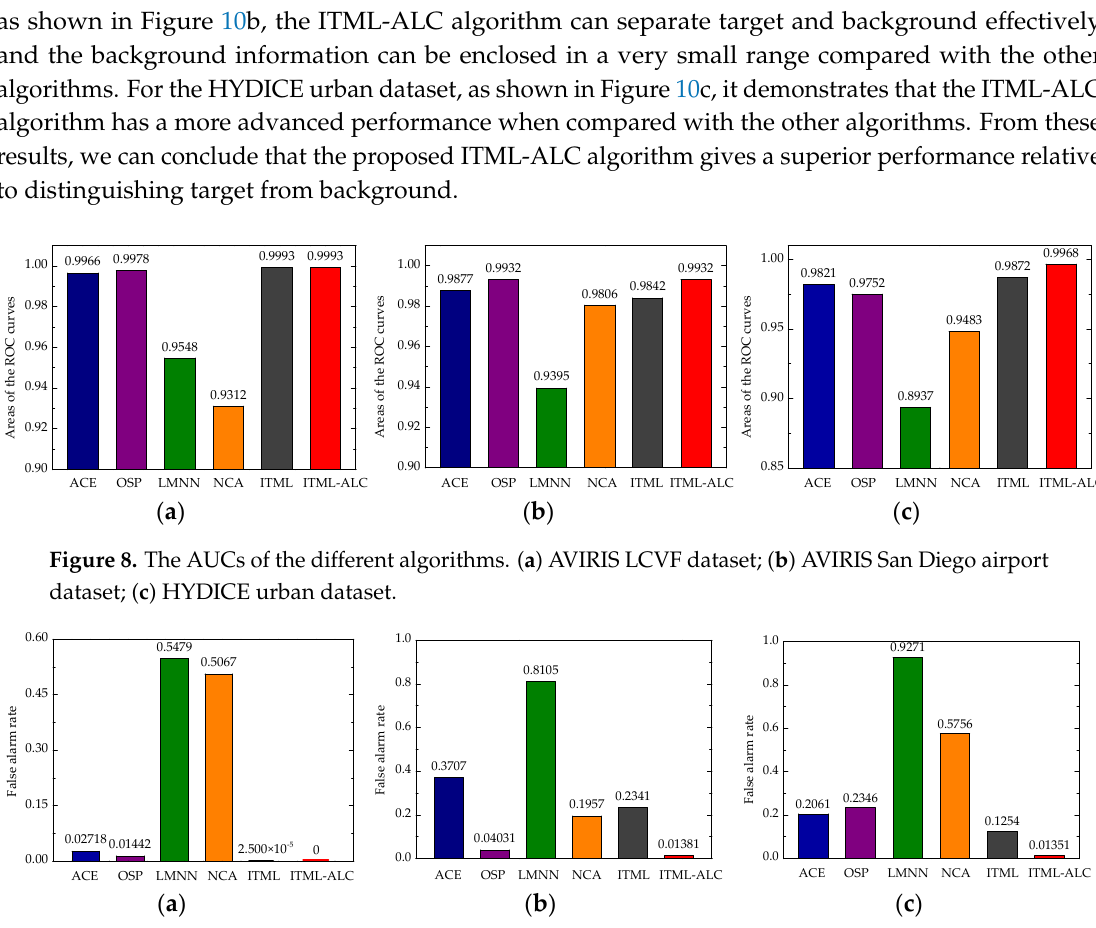
Figure 9. The FARs under 100% detection of the different algorithms. ( a ) AVIRIS LCVF dataset; ( b ) AVIRIS San Diego airport dataset; ( c ) HYDICE urban dataset.